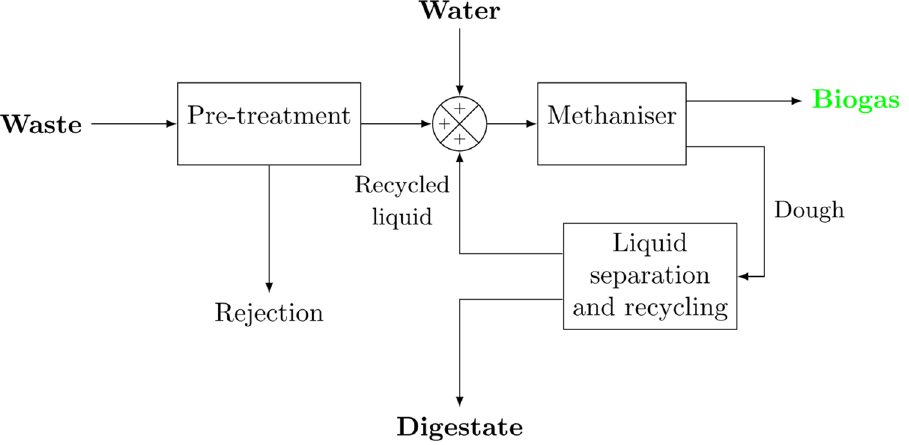
Figure 3. Block diagram of a biogas plant.